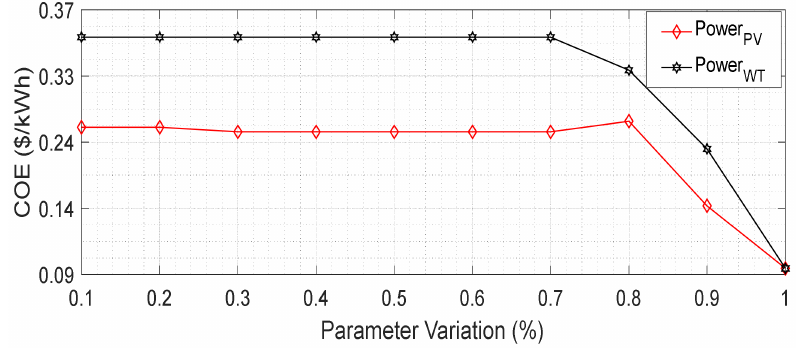
Figure 14. Sensitivity Analysis: Comparison between P PV and P WT against COE. The output generated power from the utilized sources for the proposed hybrid system is presented in Figure 11. Various samples can be taken as (a) refers to the status at 9 a.m., (b) represent the outpower at 11 a.m., sample (c) refers to 16 p.m., and at 17 p.m. for sample